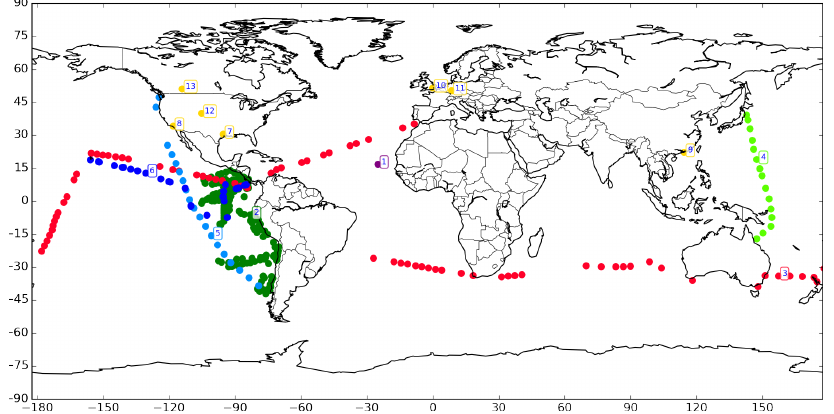
Figure 20. Locations of halogen observations against which the model is compared. IO observations are shown in different colours. ClNO 2 observations are shown in gold. BrO observations presented here were made at the same locations as IO observations. 1 indicates Cape Verde, CV (Read et al., 2008; Mahajan et al., 2010); 2 is TORERO (aircraft-based; Volkamer et al., 2015; Wang et al., 2015); 3 is Malaspina (Prados-Roman et al., 2015b); 4 is TransBrom (Prados-Roman et al., 2015b); 5 = HaloCAST-P (Mahajan et al., 2012); 6 is TORERO (ship- based; Volkamer et al., 2015; Wang et al., 2015); 7 is Texas, US (Faxon et al., 2015; Osthoff et al., 2008); 8 is California, US (Riedel et al., 2012; Mielke et al., 2013); 9 is Southern China, CN (Tham et al., 2014); 10 is London, GB (Bannan et al., 2015); 11 is Hessen,